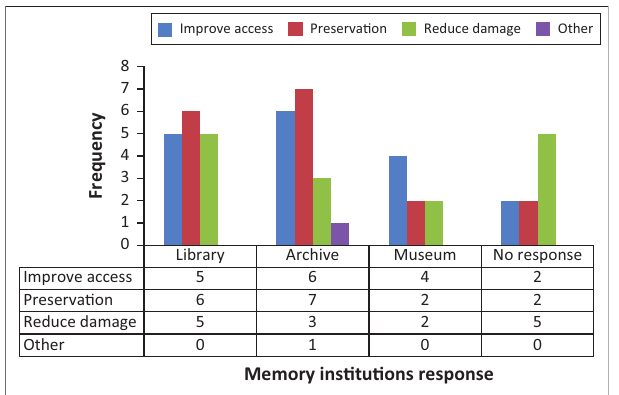
FIGURE 4: Selection criteria in libraries, archives and museums ( N = 17).